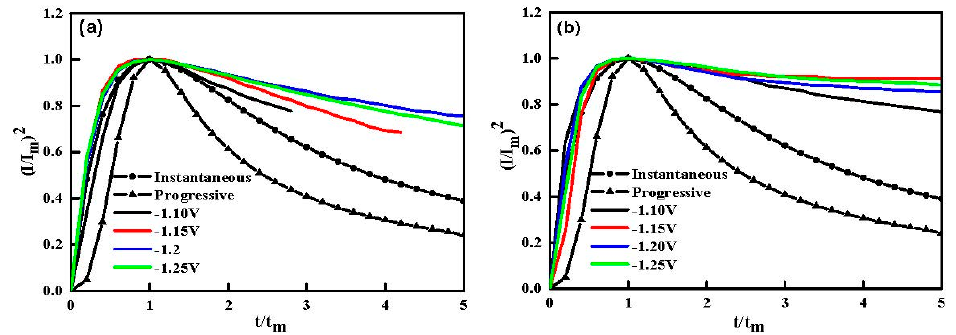
Figure 4. Dimensionless plots ( I/I m ) 2 ~ ( t/t m ): ( a ) Ni-Co layer; ( b ) Ni-Co-ZrO 2 multiple coatings, ultrasonic power 100 W, T = 40 °C and pH = 4.